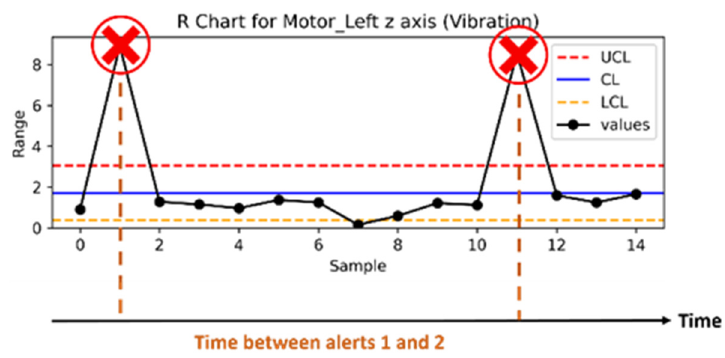
Figure 12. R control chart related to the time between alerts.